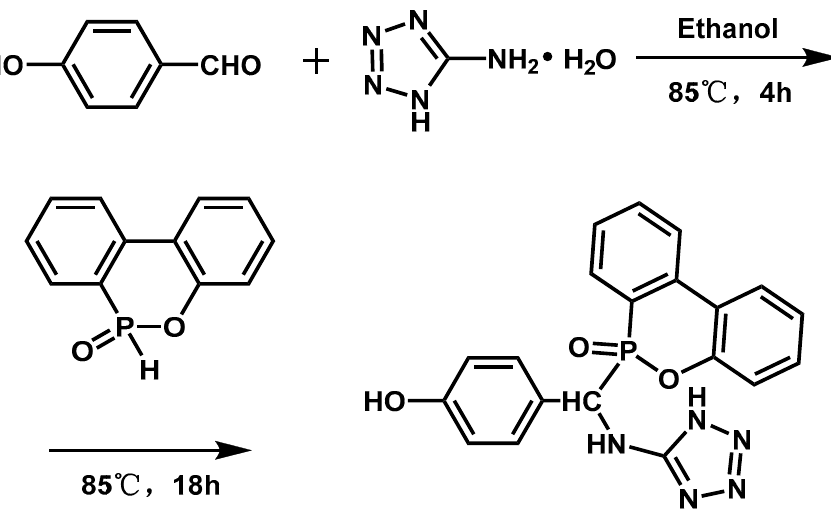
Figure 7. Synthesis route of DOPO-based tetrazole derivative (ATZ). Readapted with permission from Ref. [83], Copyright 2019, Elsevier B.V.